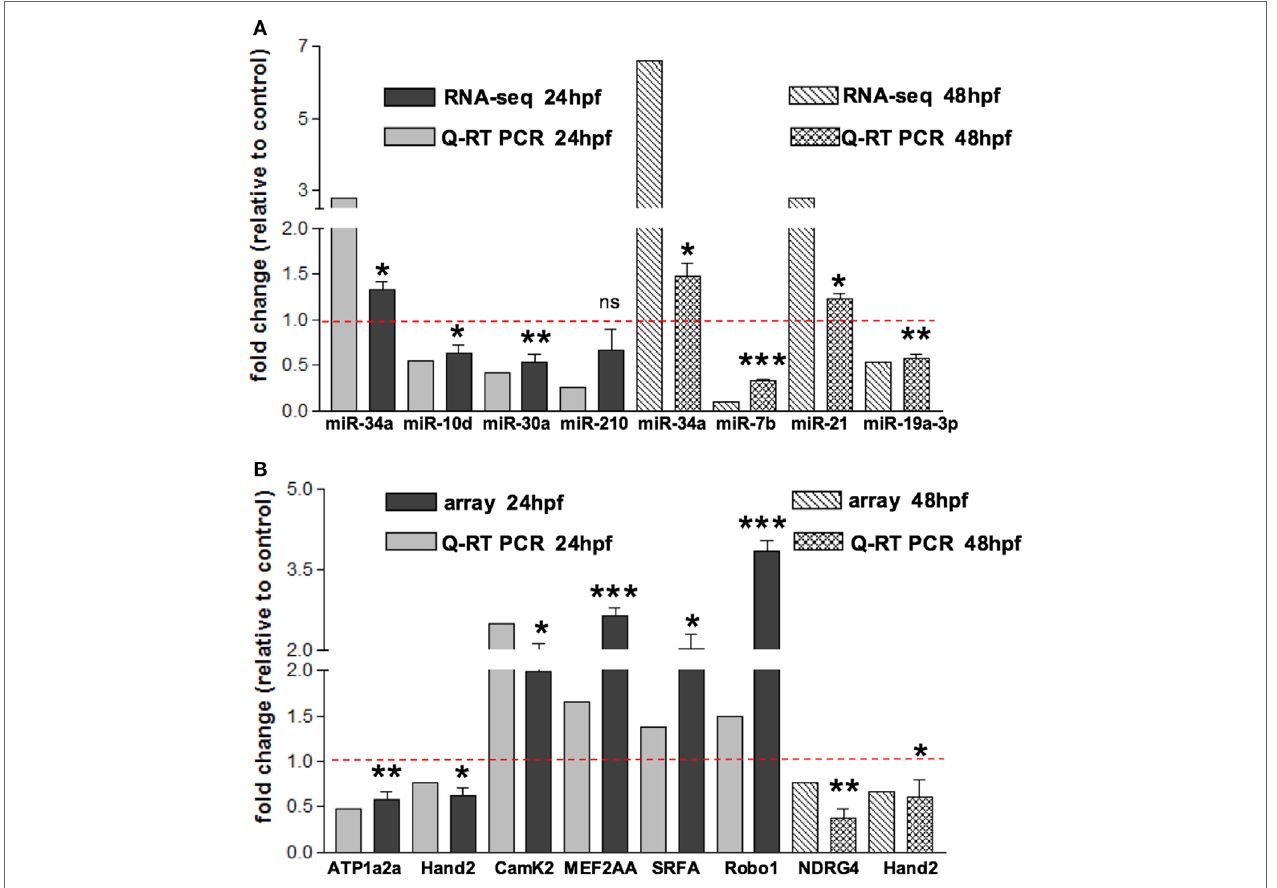
FigUre 2 | Validation of small rna seq profiling and array-based gene expression profiles by Quantitative rT-Pcr . (a) Sequencing and corresponding Q-RT PCR expressions of eight of the miRNAs reported in Table 1 and identified as differentially modulated in MO-Tbx5 vs. MO-Ct embryos at 24 hpf and at 48 hpf are reported. Values are expressed as fold change of MO-Tbx5 relative to MO-Ct. For Q-RT PCR, values are normalized on U6 expression. As pointed out in the results, miR-19a RNA-seq value is from Chiavacci et al. (2015). miR-210 is the 5p isoform. (b) Microarray and corresponding qRT-PCR expressions of eight genes showing differential expression in MO-Tbx5 compared to MO-Ct embryos at 24 and 48 hpf are reported. Values are expressed as fold change of MO-Tbx5 relative to MO-Ct. For Q-RT PCR, values are normalized on EF1, beta actin, and 18S expression. The values reported in the Q-RT PCR analysis are the mean of at least three independent microinjection experiments, t -test was used for statistical analysis: * p < 0.05, ** p < 0.01, and *** p <